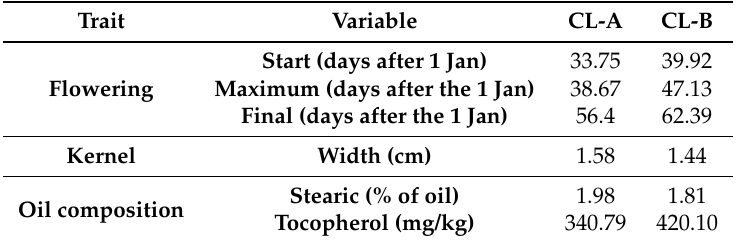
Table 6. Genetic groups identified within the collection are differentiated according to phenotypic and quality-related traits. Data are means, and clusters’ differentiation was tested by the nonparametric Wilcoxon test. Only the variables for which Prob > Chi-square was below 0.05 are